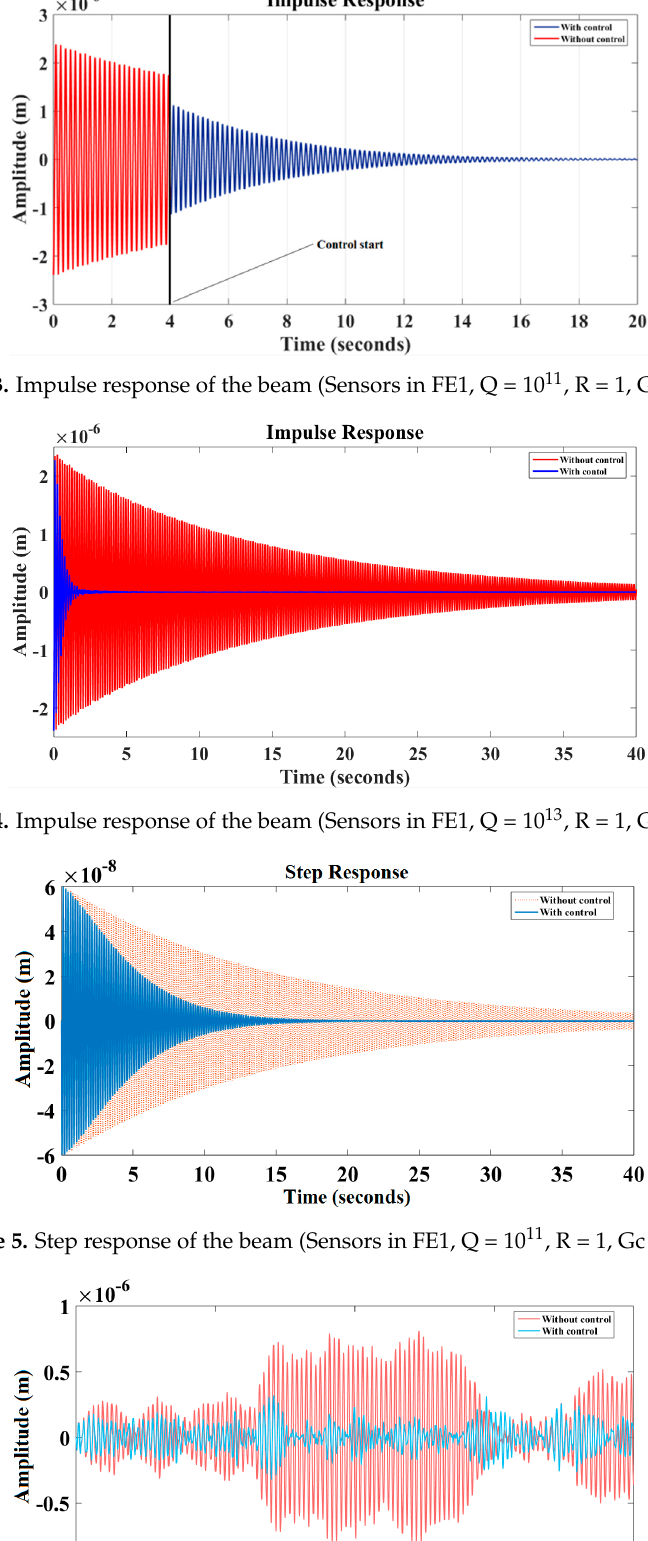
Figure 7. Impulse response of the beam (Sensors in FE2, Q = 10 11 , R = 1, Gc = 100).